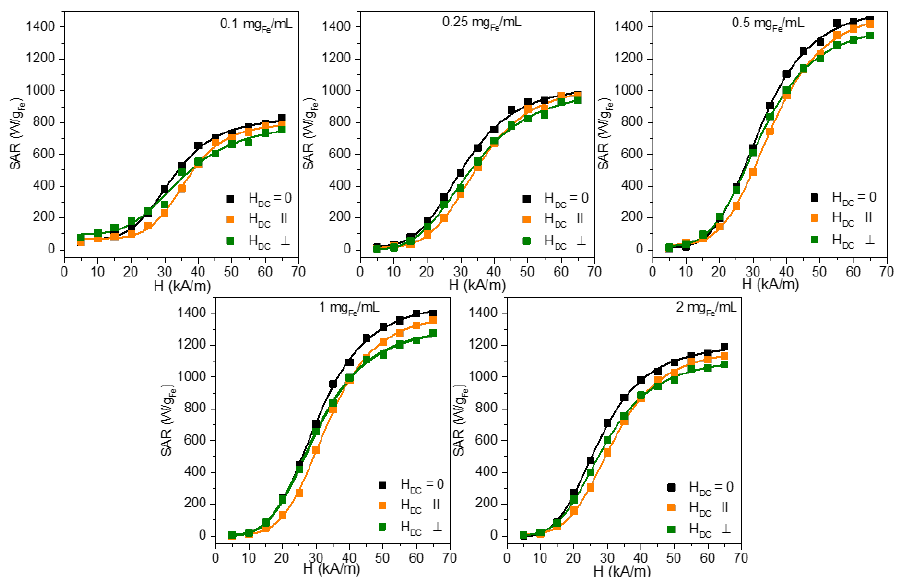
Figure 5. SAR dependence on the H for the Zn ferrites immobilized randomly in PEG 8K and submitted after cooling to the combination of the AMF and H DC (10 kA/m) in the parallel and perpendicular configurations in the concentration range of 0.10–2.00 mg Fe /mL.